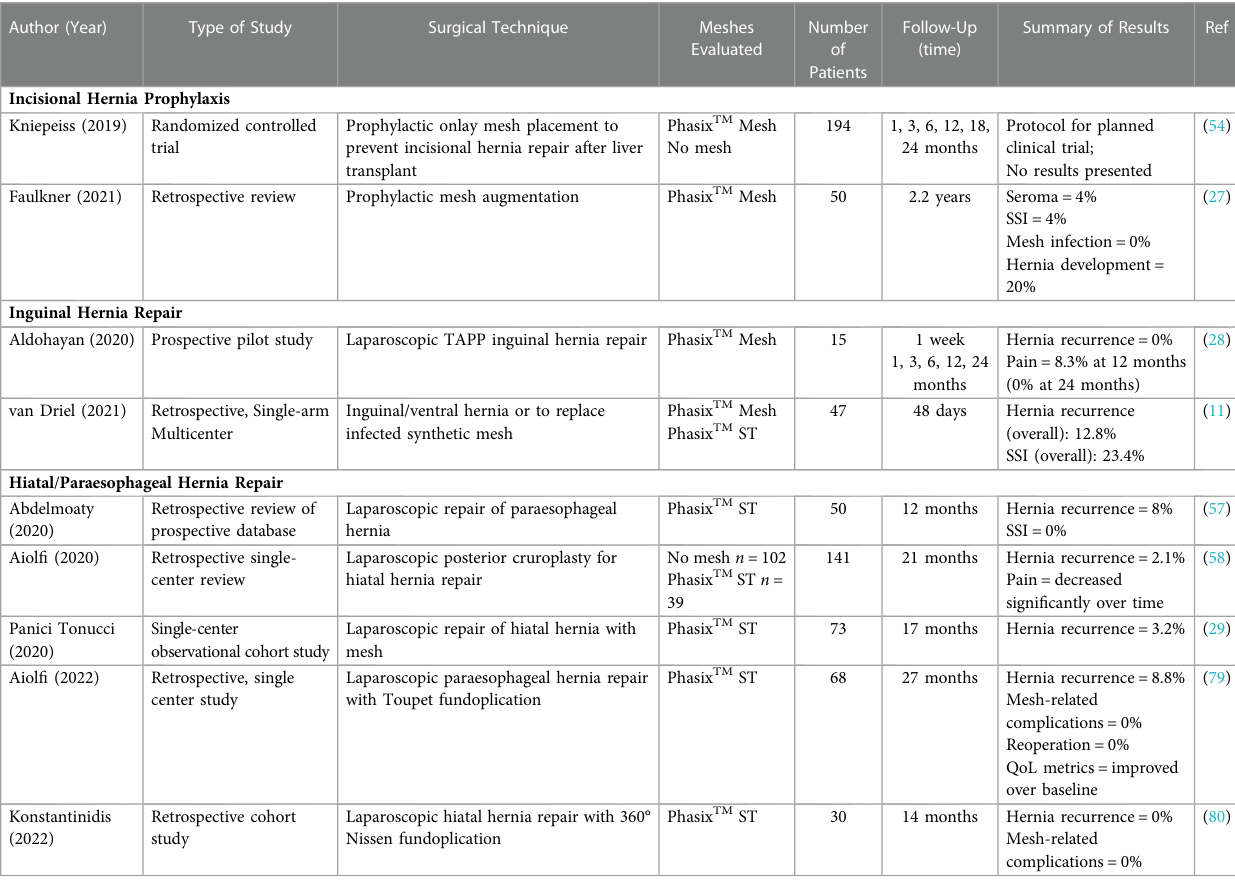
TABLE 2 Clinical outcomes associated with P4HB mesh in incisional hernia prophylaxis, inguinal hernia repair, and hiatal/paraesophageal hernia